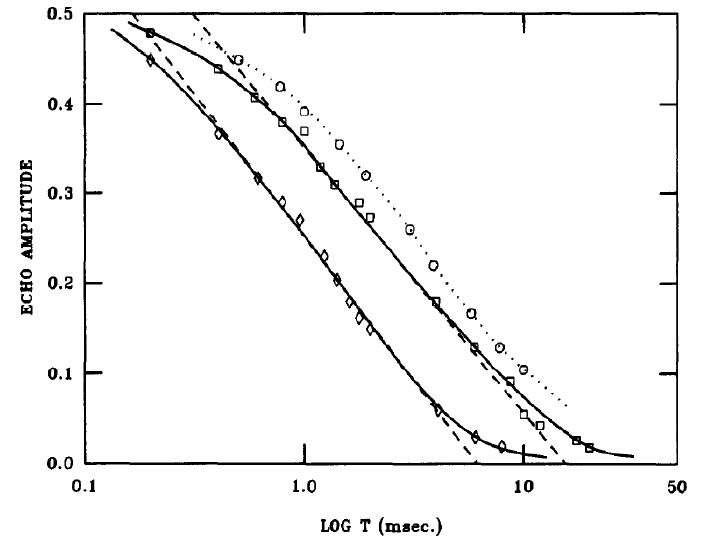
Figure 17. Decay of NMR stimulated echos for the glass state of ortho-para hydrogen mixtures. Reproduced with permission from [39]. Copyright Elsevier,